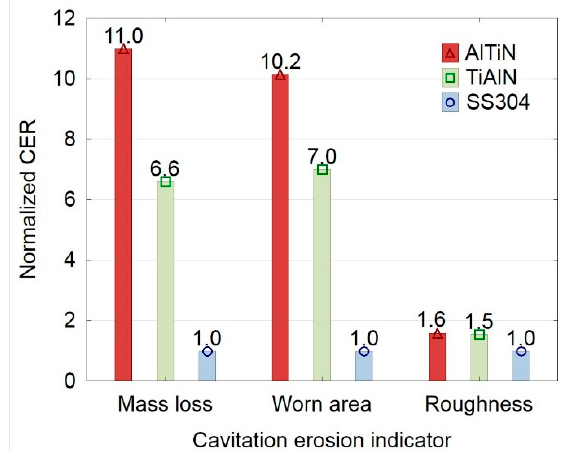
Figure 6. Cavitation erosion resistance (CER) calculated in reference to SS304 based on mass loss (mg), worn area percentage (%) and roughness parameter Sa ( µ m), 4.5 h of cavitation test.